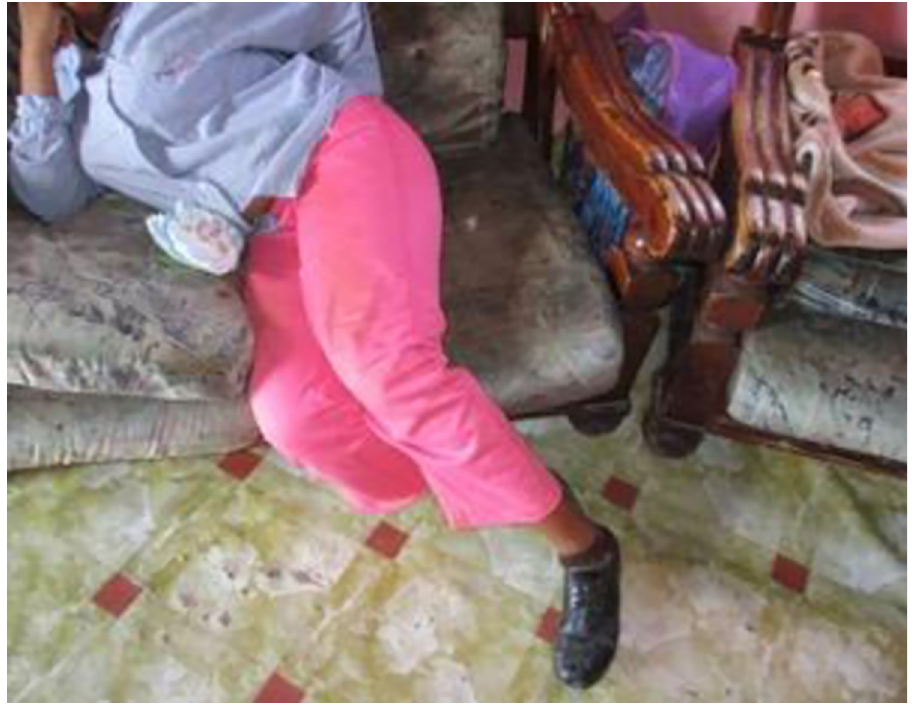
Fig 12. Image from co researcher